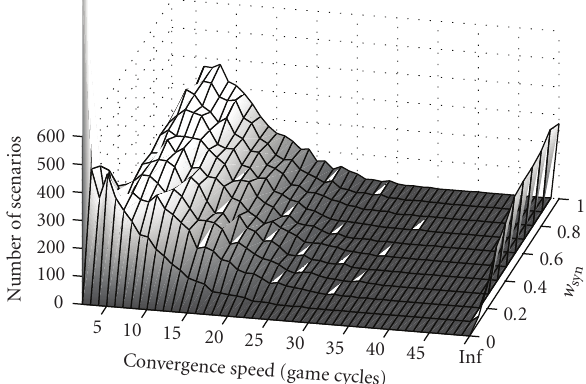
Figure 5: Weights exploration for a 5 × 5-processor array. The x -axis represents the number of scenarios over 50 000 simulations. The y - axis shows the convergence speed in game cycles, while the z -axis explores the weight of the synchronization metric w syn . The inf label on the y -axis denotes those cases which do not converge.